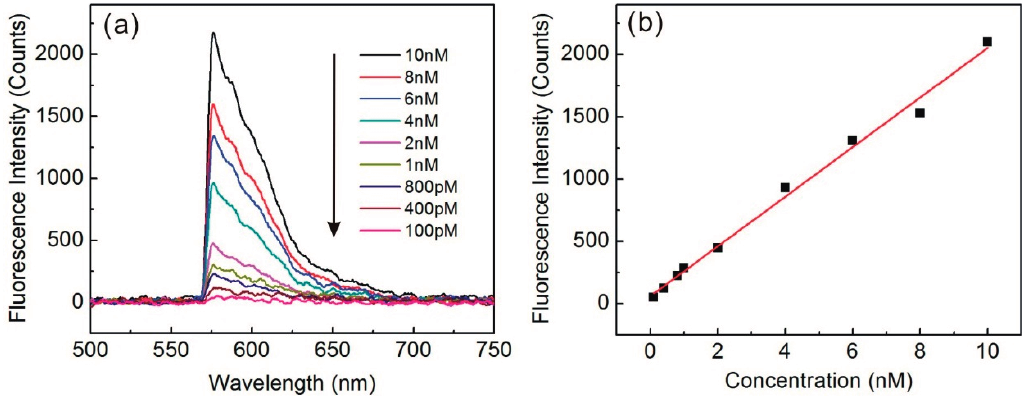
Figure 2. ( a ) Fluorescence spectra of R6G at different concentrations; ( b ) Fluorescence peak intensity as a function of concentration of